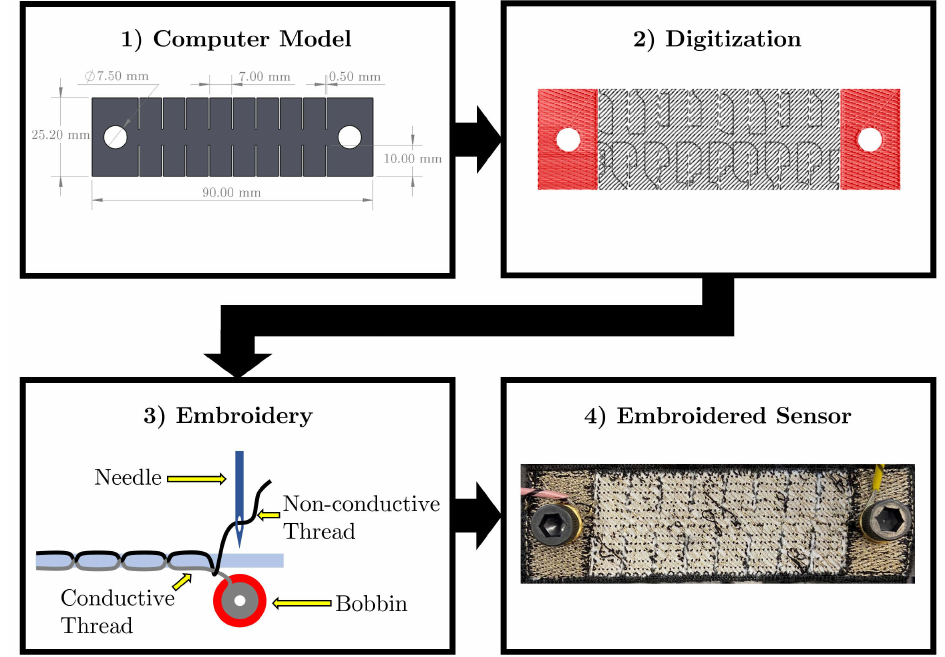
Figure 3. Design process of the embroidered textile strain sensor. First, a CAD model of the sensor is created. Then, the CAD model is digitized to produce an embroidery compatible file that will be read by an embroidery machine. Finally, the sensor is embroidered based on a set of specifications defined during the digitization